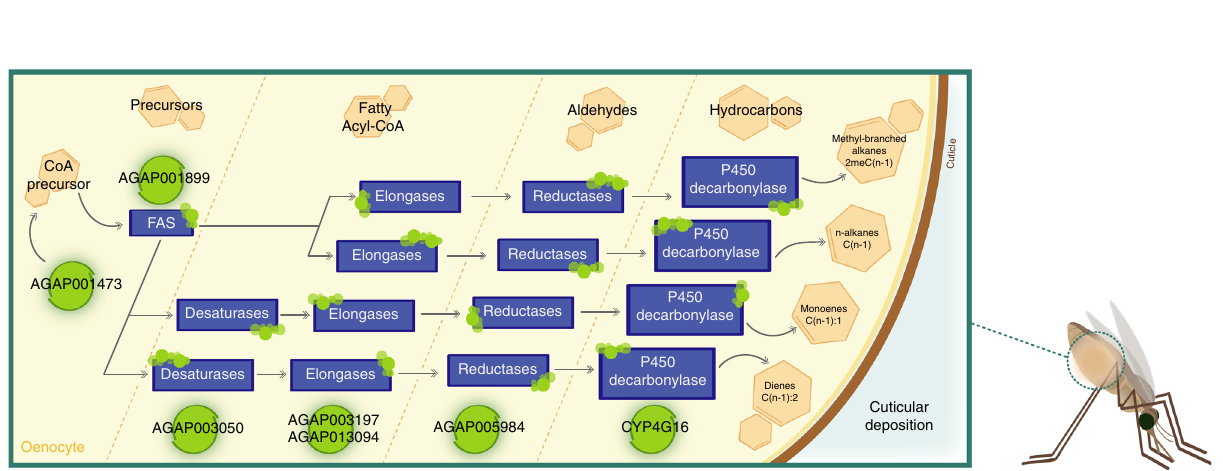
Fig. 5 Graphical Outputs from IR-TEx App. These panels represent three graphical outputs from the IR-TEx App, each of which is available in downloadable tabular formats. These outputs result from a user inputted VectorBase ID, selected fi ltering criteria based on meta-data and fi nally, user inputted correlation value. Each panel here is AGAP001076-RA ( CYP4G16 ). a Log 2 fold change of CYP4G16 ( y ) across each microarray experiment meeting pre- selected user criteria ( x ), here all data is selected. b Each point represents a dataset with signi fi cant differential expression of CYP4G16 and the associated approximate collection site. Green points show signi fi cant down regulation of CYP4G16 , orange points show signi fi cant fold changes of 1-5 and red a fold change of >5 compared to susceptible controls. Map data source: Google Maps, 2018. c Log 2 fold change ( y ) across each microarray experiment meeting pre-selected user criteria ( x ) for each transcript showing a correlation of |r| ≥ 0.85 for CYP4G16